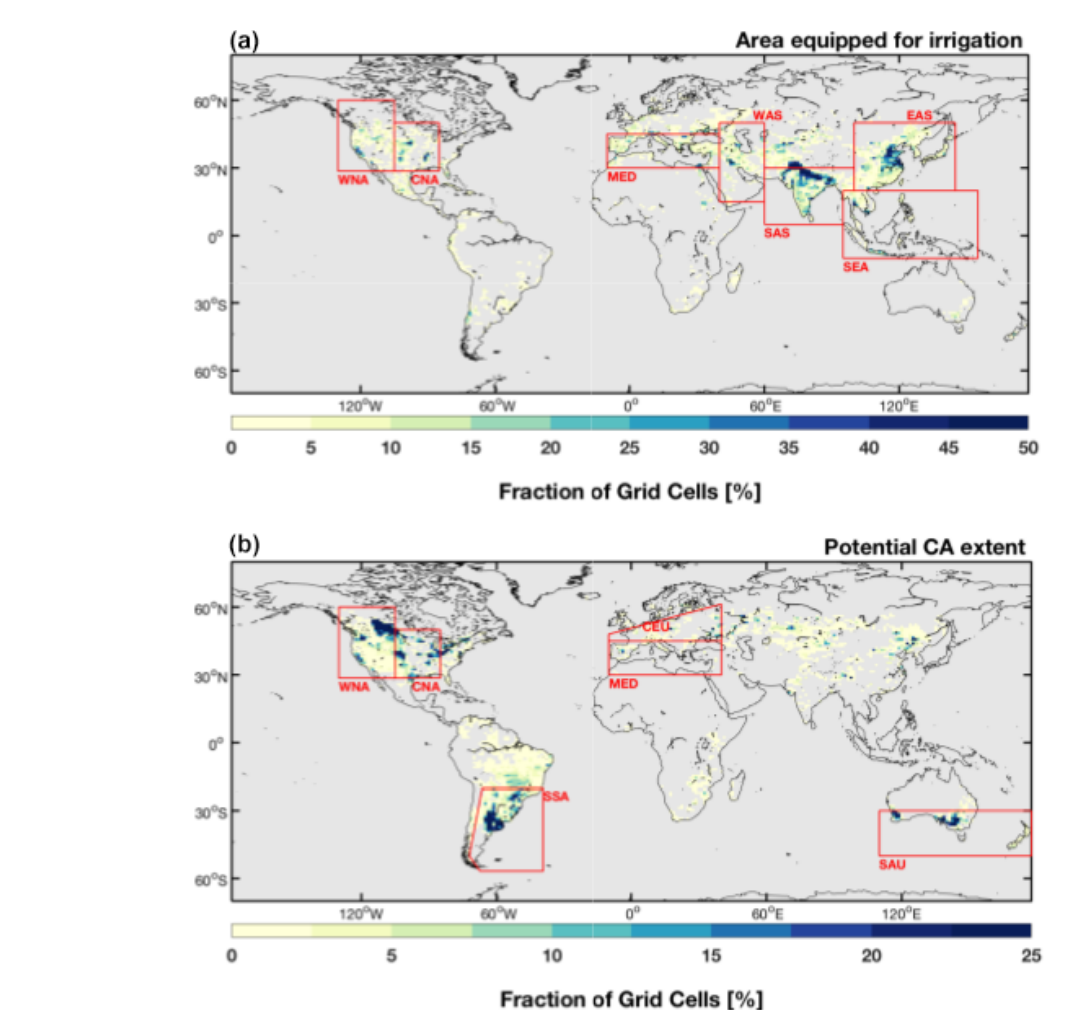
Figure 1. (a) Percentage of each grid cell equipped for irrigation (%) (Siebert et al., 2005). (b) Potential estimate of CA extent mapped to the CLM crop PFT (Prestele et al., 2018). The red boxes in (a) denote the regional domains where irrigation is extensive and which were thus examined in greater detail including western North America (WNA), central North America (CNA), south Europe and the Mediterranean (MED), West Asia (WAS), South Asia (SAS), Southeast Asia (SEA), and East Asia (EAS). The red boxes in (b) denote the regional domains where CA is extensive and which were thus examined in greater detail including WNA, CNA, MED, southeastern South America (SSA), central Europe (CEU) and southern Australia